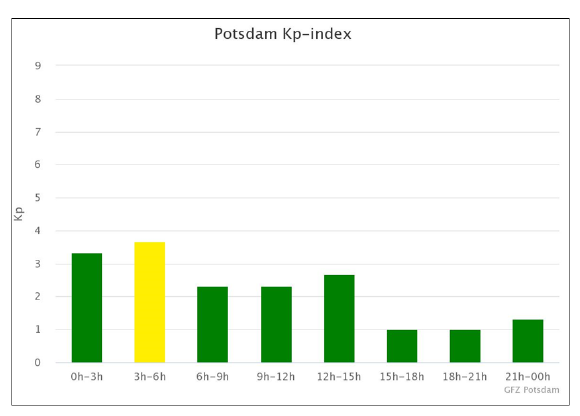
Figure 5 . Official Kp indices on 1 st January 2018. Figure 6 illustrates the time series of RMSE values for VTEC- Maps and IRI-2016 VTEC maps on 1 st January 2018. The RMSE values of produced VTEC-Maps compared to the RMSE values of IRI-2016 VTEC maps have been reduced in the range of [1.65, 2.81] TECU equal to 70-85 percent and totally the RMSE values reduced with an average of 1.93 TECU during the selected day.